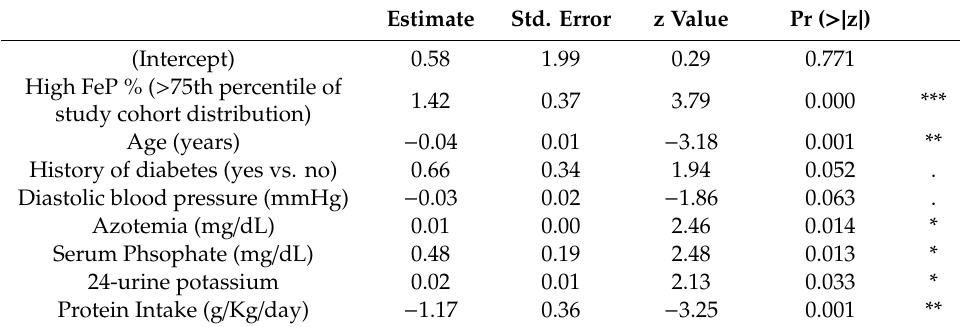
Table 5. Most parsimonious model (logistic regression analysis) to predict CKD progression.